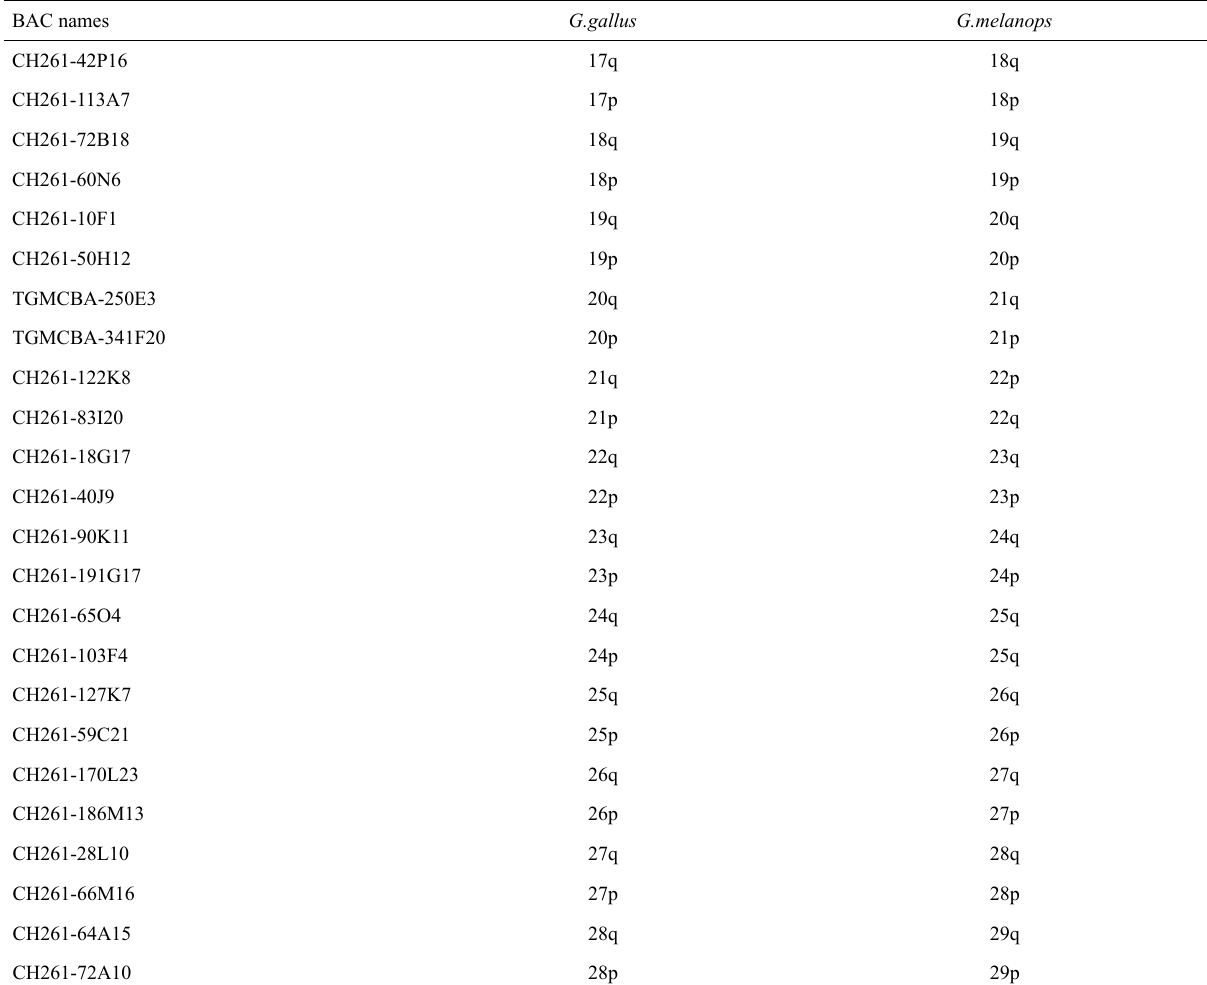
Table 2 – Correspondence between Gallus gallus BACs from microchromosome and Gallinula melanops